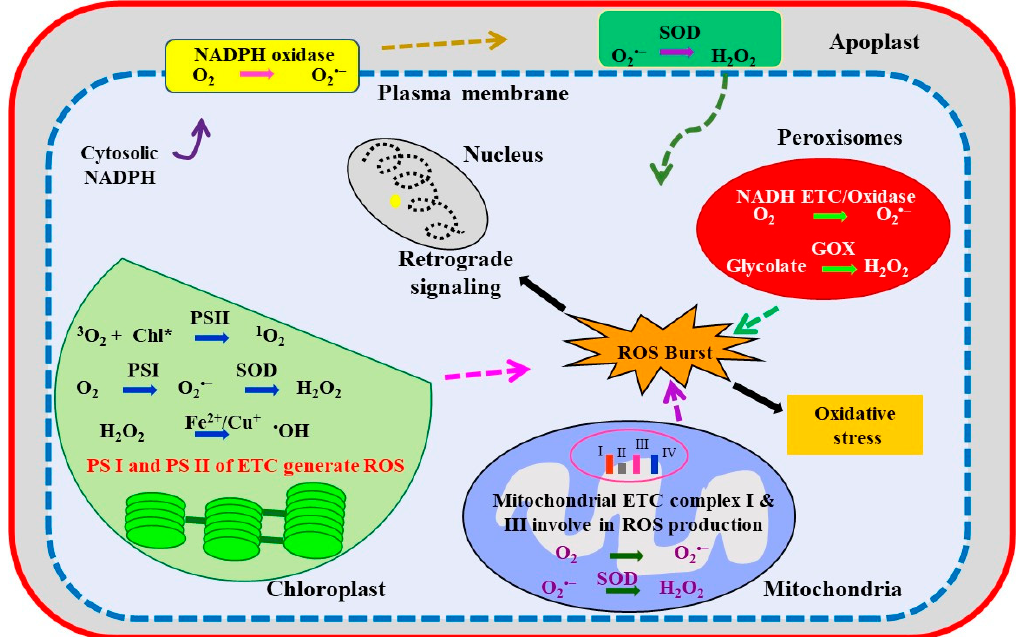
Figure 2. Abiotic stresses induced the production of ROS in different plant cell organelles which either initiate signaling (retrograde) or cause oxidative stress. In chloroplast singlet oxygen ( 1 O 2 ), superoxide radical (O 2•– ), hydrogen peroxide